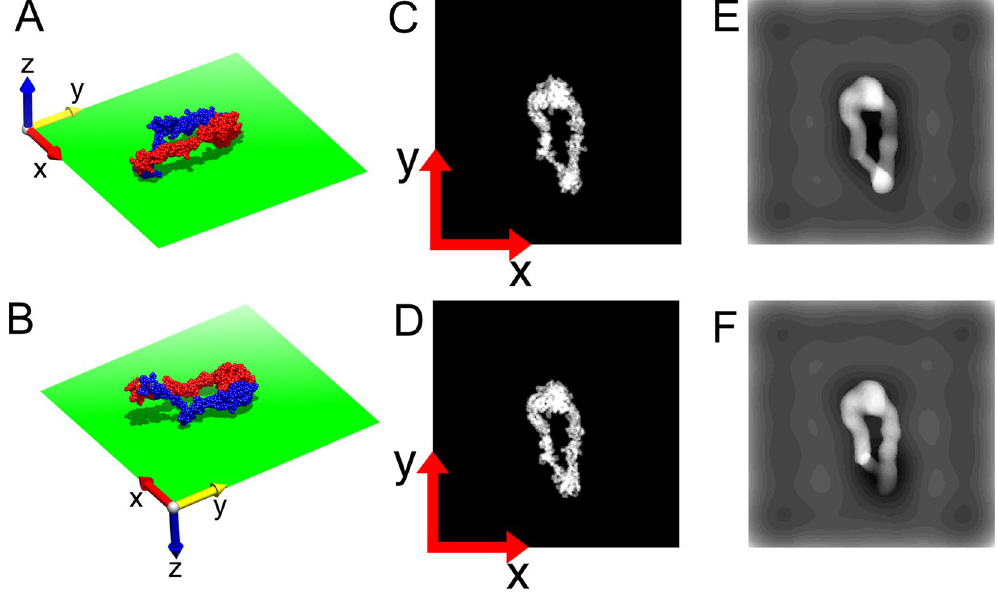
Figure 1. Example where atomic models with different conformations and orientations form similar simple projections. ( A , B ) Atomic models of integrins represented by sphere models ( α -chain in red, β -chain in blue) contacting the supporting films represented by green rectangles. The arrows represent the axes of the coordinate system. These models are projected along the negative direction of the z -axis. ( C , D ) Simple projection models of ( A , B ), respectively. ( E , F ) Negative stain models of ( A , B ), respectively. The stain thickness h was set to 30 Å in both